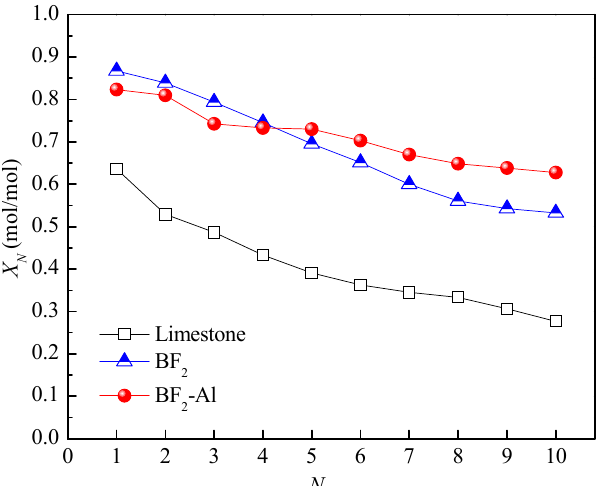
Figure 3. Effect of Al 2 O 3 loading on cyclic energy storage performance of templated CaO-based materials.